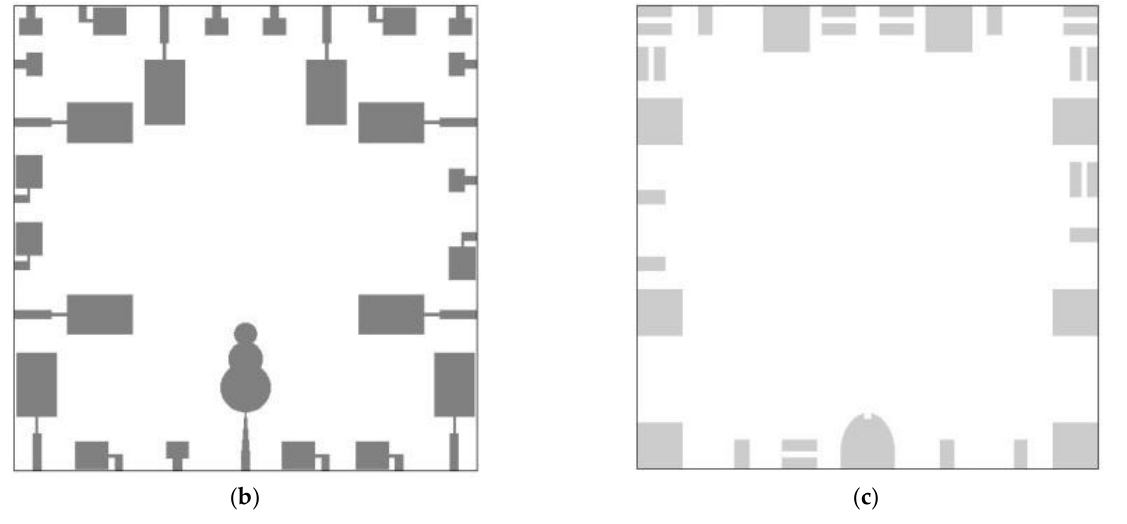
Figure 1. Geometry of the 25-port CR MIMO antenna. ( a ) Structure of the antenna. ( b ) Top view. ( c ) Back view. Table 1. Specifications of the 25-port CR MIMO antenna.